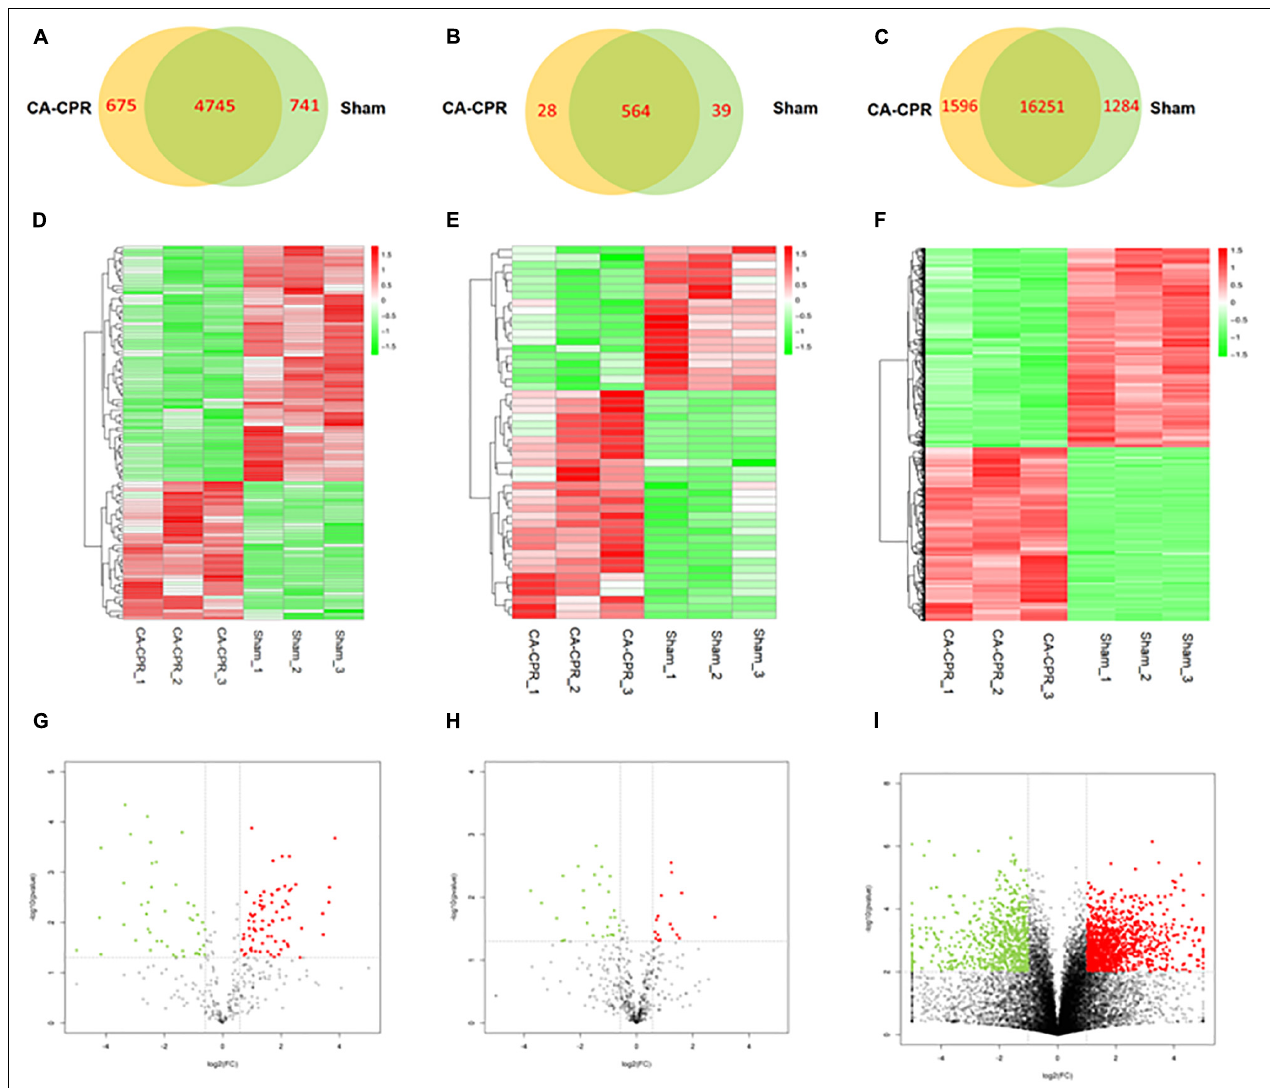
FIGURE 2 | Analysis of the RNAs expression profiles in the two groups. (A) to (C) showed the Wayne diagram analysis of all the differentially expressed lncRNAs (A) , miRNAs (B) and mRNAs (C) in the rat heart tissues of the two groups; (D) to (E) showed the heatmap clustering analysis of the differentially expressed lncRNAs (D) , miRNAs (E) , and mRNAs (F) between the two groups; (G) to (H) showed the volcano atlases of the differentially expressed lncRNAs (G) , miRNAs (H) and mRNAs (I) in the two